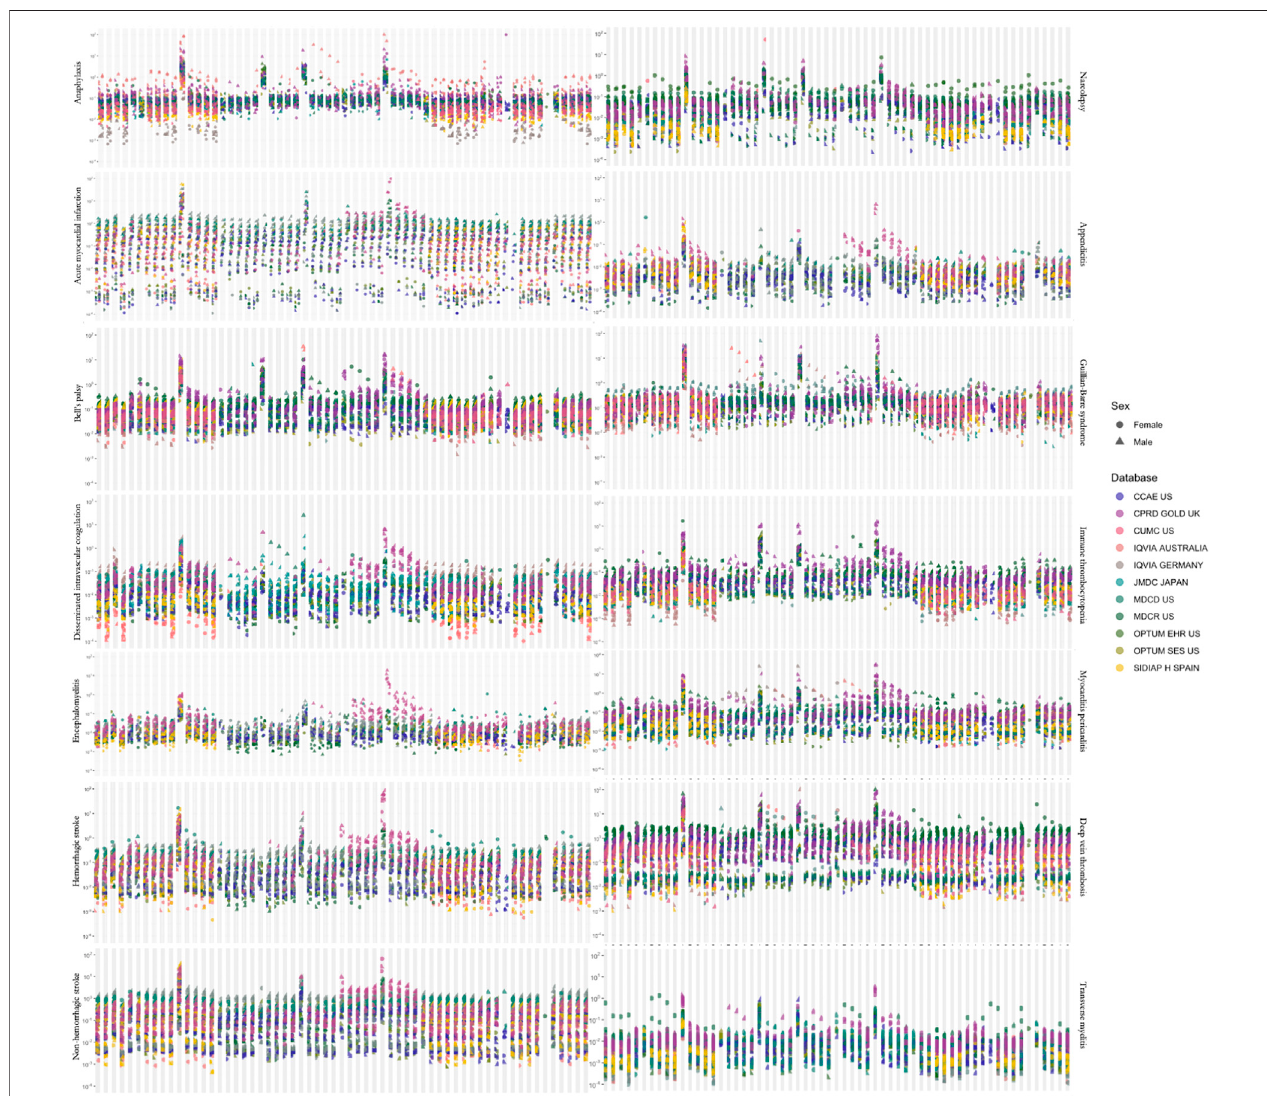
FIGURE2| Estimatedincidenceratesforadverseeventsofinterestacrossall (A) targetpopulations, (B) time-at-riskintervalsand (C) agegroups.Adotrepresents one incidence rate estimate.